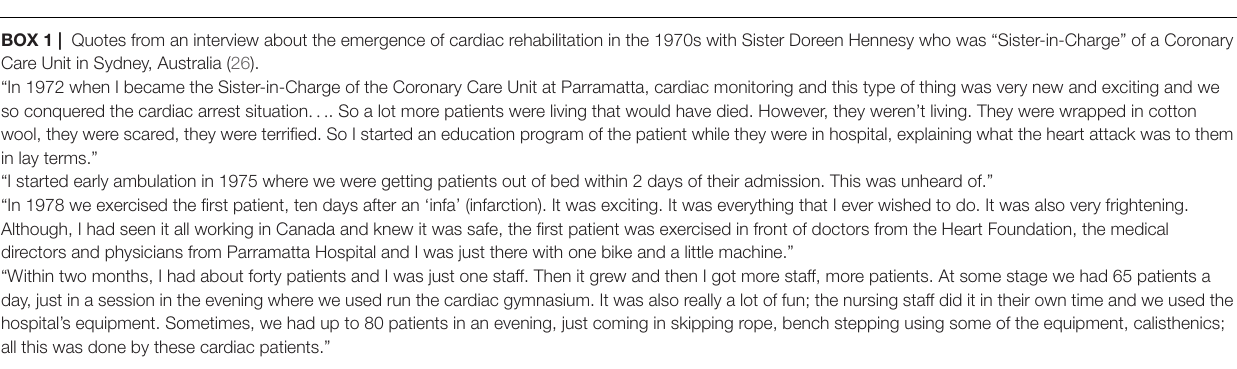
FIGURE 1 | Timeline for cardiac rehabilitation in the context of acute care and transformation and societal change. PCI, percutaneous coronary intervention; CABG, coronary artery bypass graft surgery; ICU, intensive care unit.